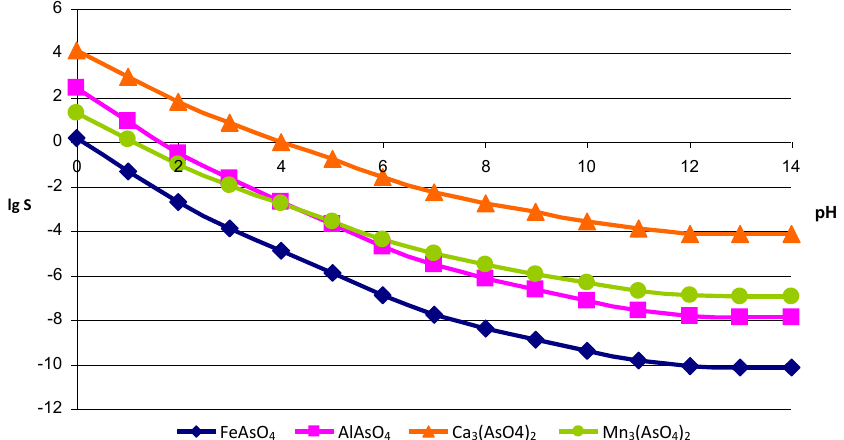
Fig. 3. Effect of pH on the solubility of some arsenates.